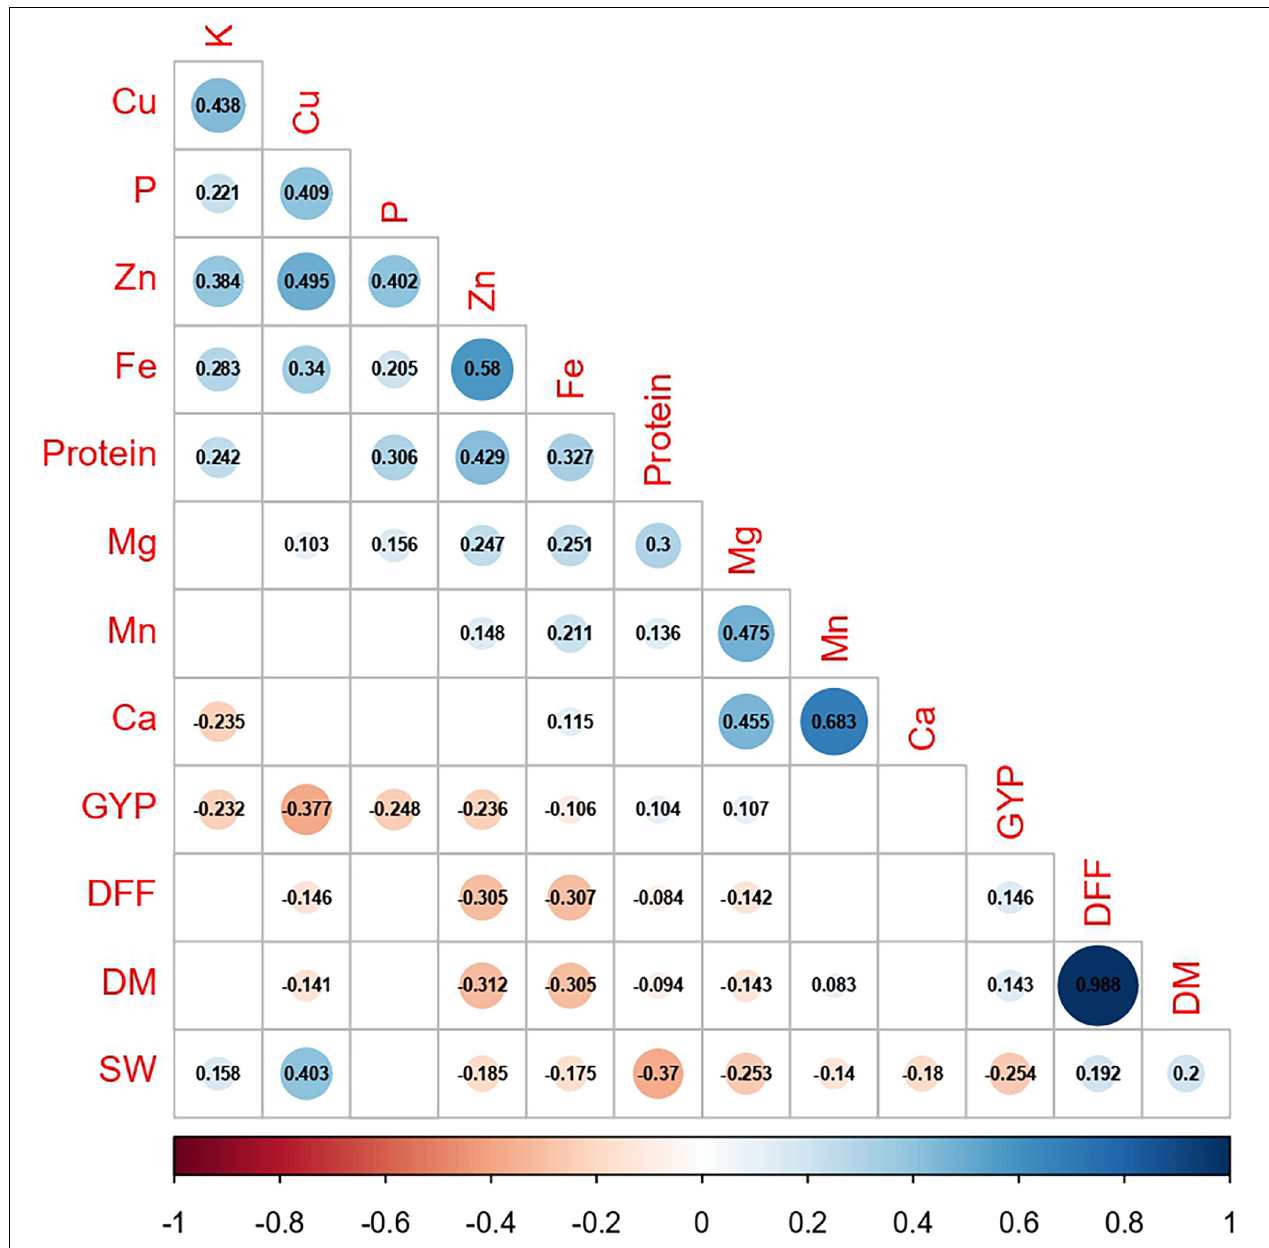
FIGURE 5 | Correlation between agronomic traits and grain nutrients pooled over two cropping years (DFF, days to 50% flowering; DM, days to maturity; SW, 100-seed weight; GYP, grain yield per plant; P, phosphorus; K, potassium; Ca, calcium; Cu, copper; Mg, magnesium; Mn, manganese. Fe, iron; Zn, zinc, respectively. The values represent the significance at p ≤ 0.05; blanks represent insignificance at p ≤ 0.05).